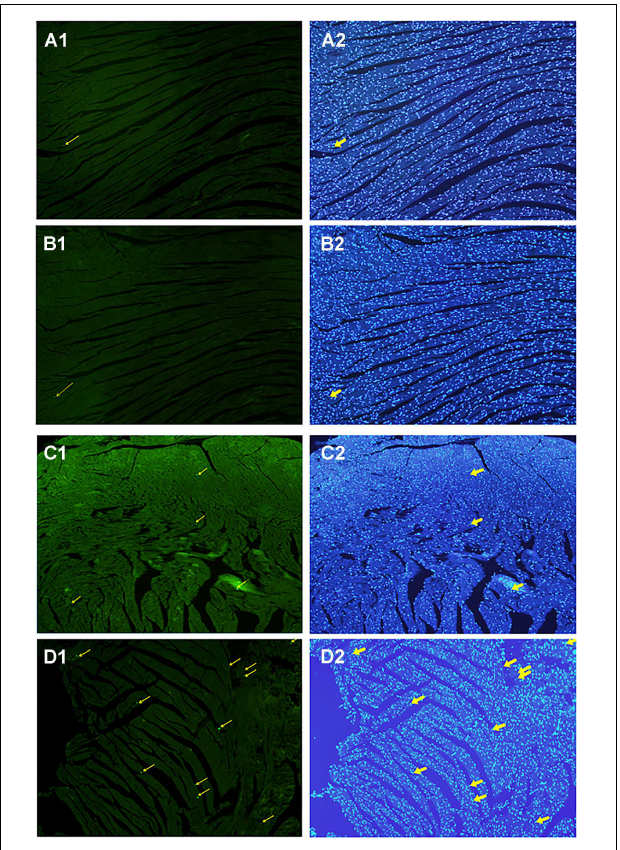
FIGURE 6 | Detection of apoptotic cardiomyocytes with the TUNEL assay on the 72nd day. Apoptotic cells were labeled green and are indicated by the yellow arrows (left panel) and the corresponding cardiomyocyte were stained blue with DAPI (right panel). (A) Normal control 2 group, (B) Normal+IVA group, (C) CVMC+IVA group, and (D) CVMC2 group.